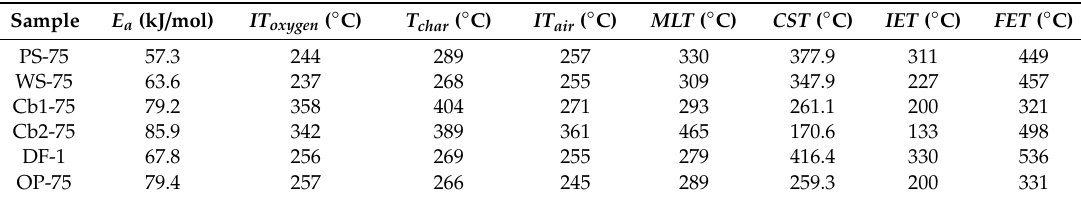
Table 3. Main combustion